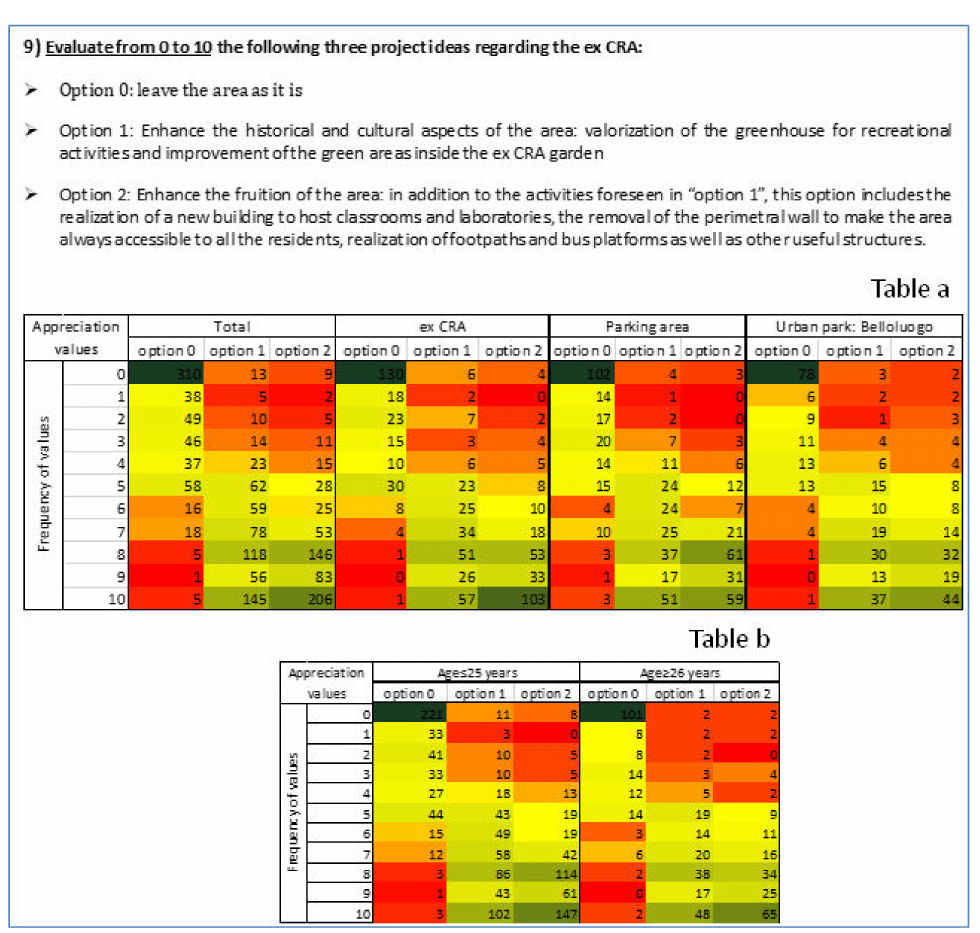
Figure 10. Heat map for the analysis of the results for the three project alternatives, considering the di ff erent survey areas and the age of respondents. The colors from red to green represent a gradient of preference from low preference to high preference in relation to the number reported in the cells of the table. ( a ) The answers were analyzed, considering both the single survey areas and the whole. ( b ) The answers were analyzed considering two age groups: under 25 years and over 25